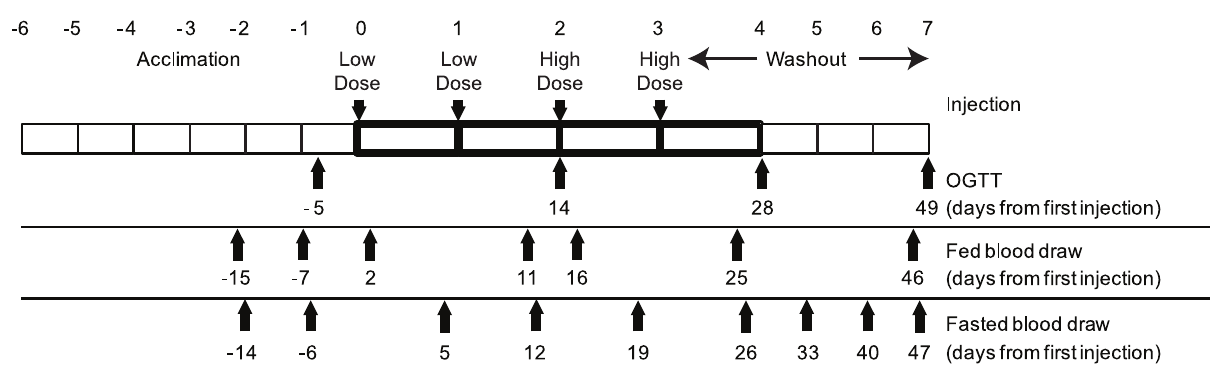
Figure 4. Design of C3201-HSA functional study. The study consisted of a four week acclimation period, four once weekly doses of C3201-HSA and a three week wash out period. Dates for collecting blood draws are indicated. These samples were tested for blood chemistry, C3201-HSA concentration and presence of anti-drug antibody. Body weight was determined once per week on the day that the animals were dosed. Forty animals were randomly assigned to four groups of ten. Group one was treated with Avimer vehicle (20 mM Tris-HCl, pH 7.4, 150 mM NaCl, 1 mM CaCl2). Group two was treated with a low dose of C3201-HSA (0.5 mg/kg/week, weeks 1 and 2, 1 mg/kg/week, weeks 3 and 4). Group three was treated with a high dose of C3201-HSA (2.5 mg/kg/week, weeks 1 and 2, 5 mg/kg/week, weeks 3 and 4). Group four was treated with of a positive control long-acting FGF21 variant Fc-FGF21 with a 3 mg/kg dose once per week.